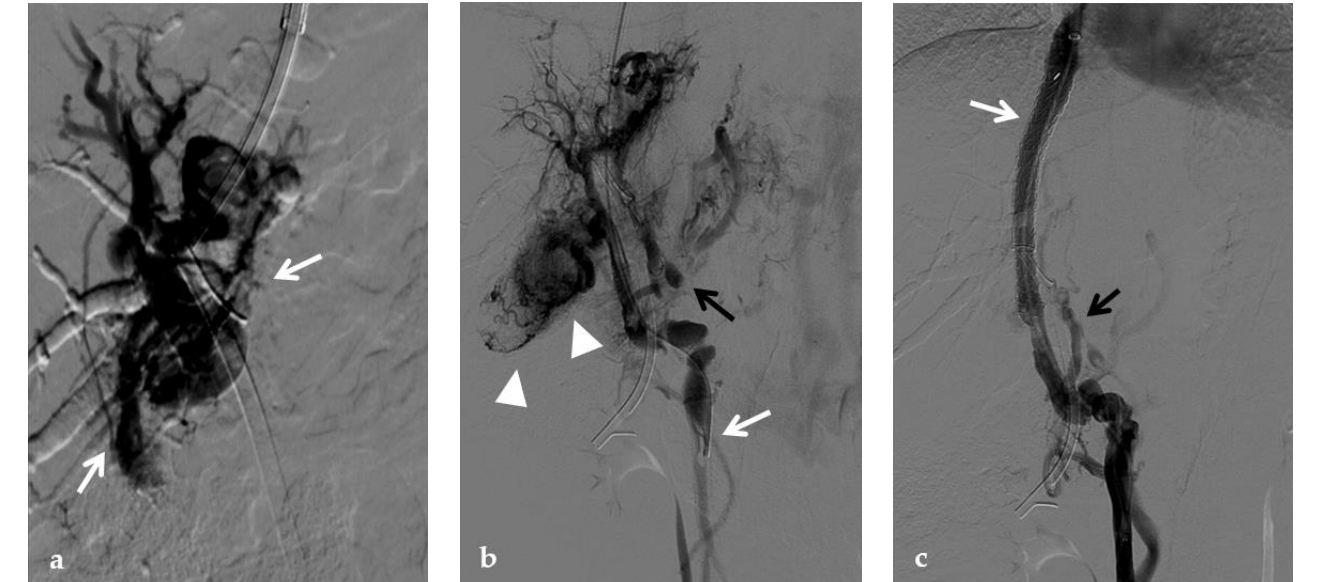
Figure 13. Anteroposterior view of a transjugular intrahepatic portosystemic shunt portography imaging series in the same patient of Figure 2. ( a ) Transjugular intrahepatic portal puncture confirms the chronic occlusion of the main portal vein with intrahepatic cavernous transformation (arrows). ( b ) After transjugular catheterization of the main cavernous vessel portography shows a patent superior mesenteric vein (white arrow) with other minor cavernous vessels at the hepatic hilum (black arrow). Note the aberrant paracholecystic veins forming portoportal collaterals to bypass the obstructed segment of the portal vein (arrowheads). ( c ) Portography performed after transjugular intrahepatic portosystemic shunt placement shows regular stent opacification (white arrow), with reduced visualization of the cavernoma (black arrow) and disappearance of paracholecystic veins.